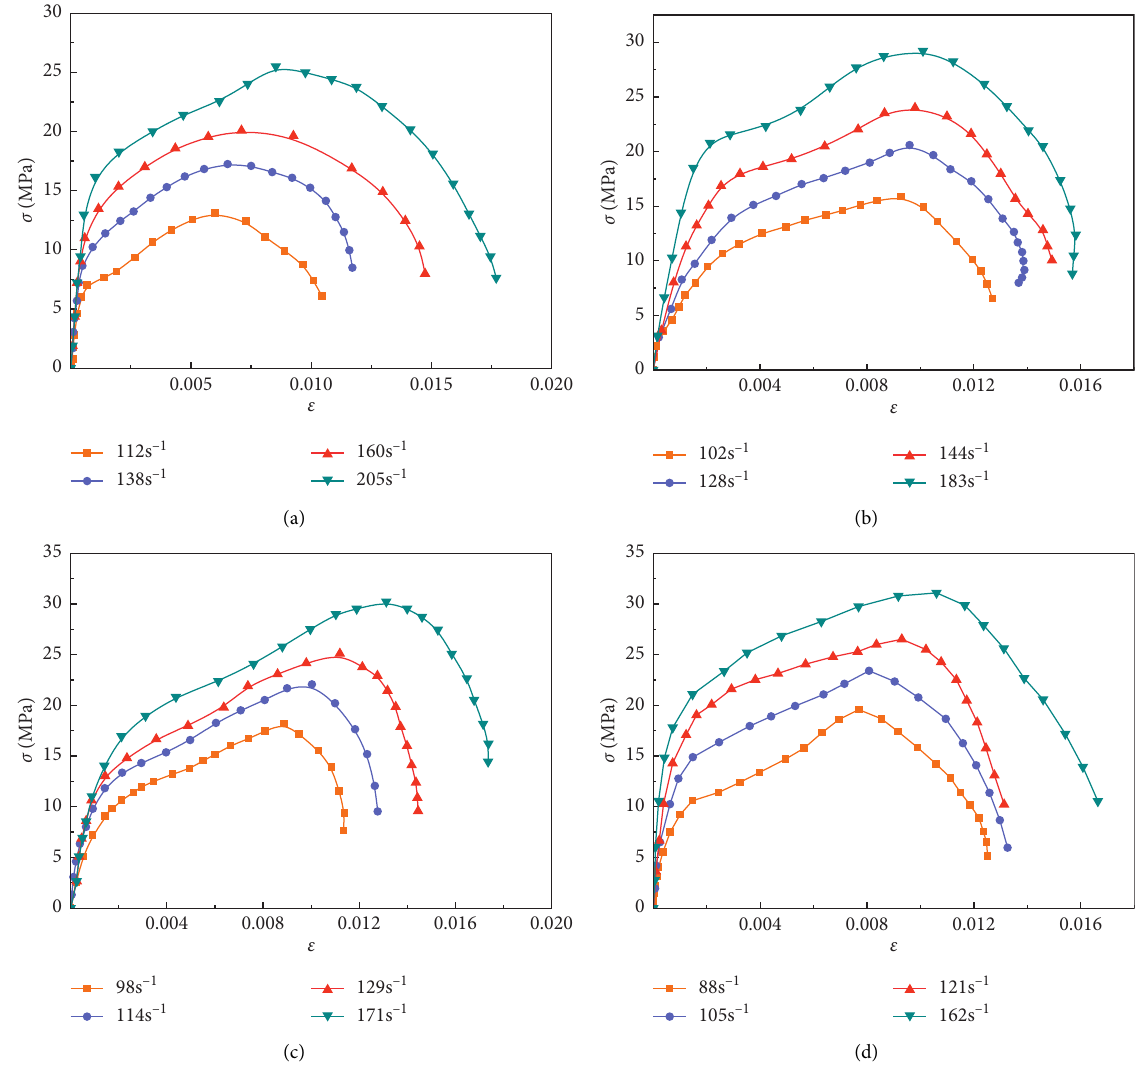
Figure 2: Dynamic stress-strain curves of red sandstone. (a) T � 0 ° C. (b) T �− 10 ° C. (c) T �− 20 ° C. (d) T � − 30 °